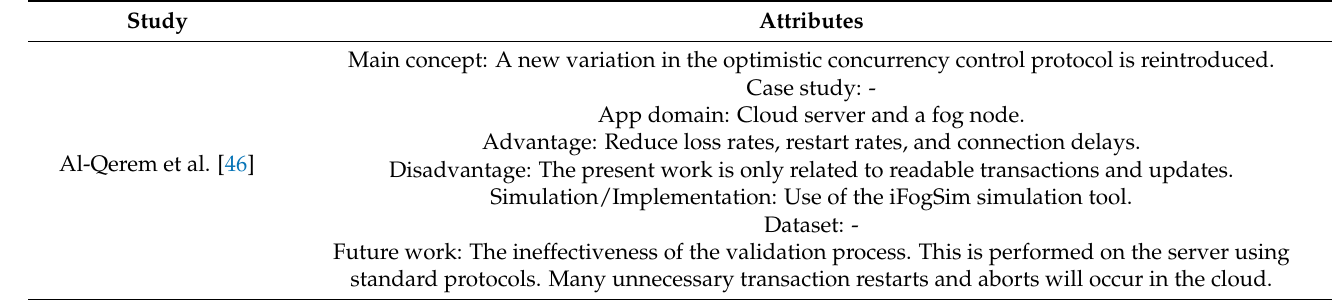
Table 20. Categorizing the state-of-the-art in other areas of